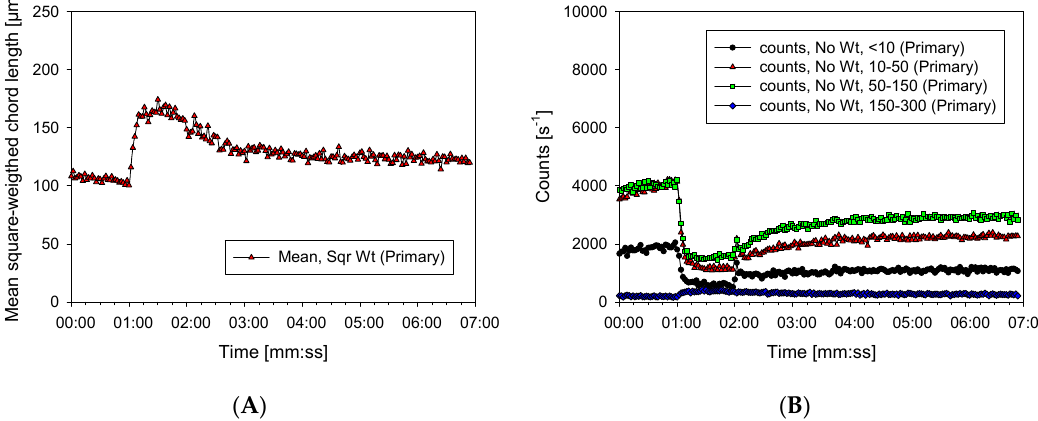
Figure 8. ( A ) Mean square chord length and ( B ) counts evolution of suspension: 5 ppm of guar gum added after 1 min (MIBC 20 ppm, PAX 75 ppm).